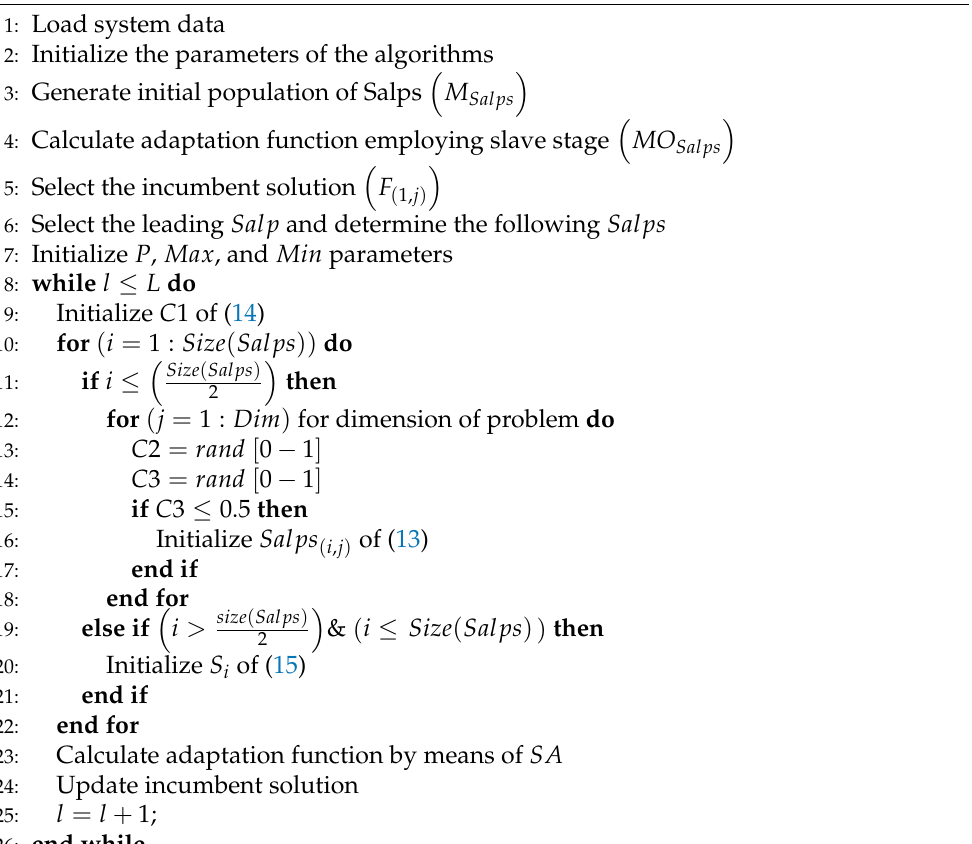
Algorithm 1 Hybrid SSA-SA optimization